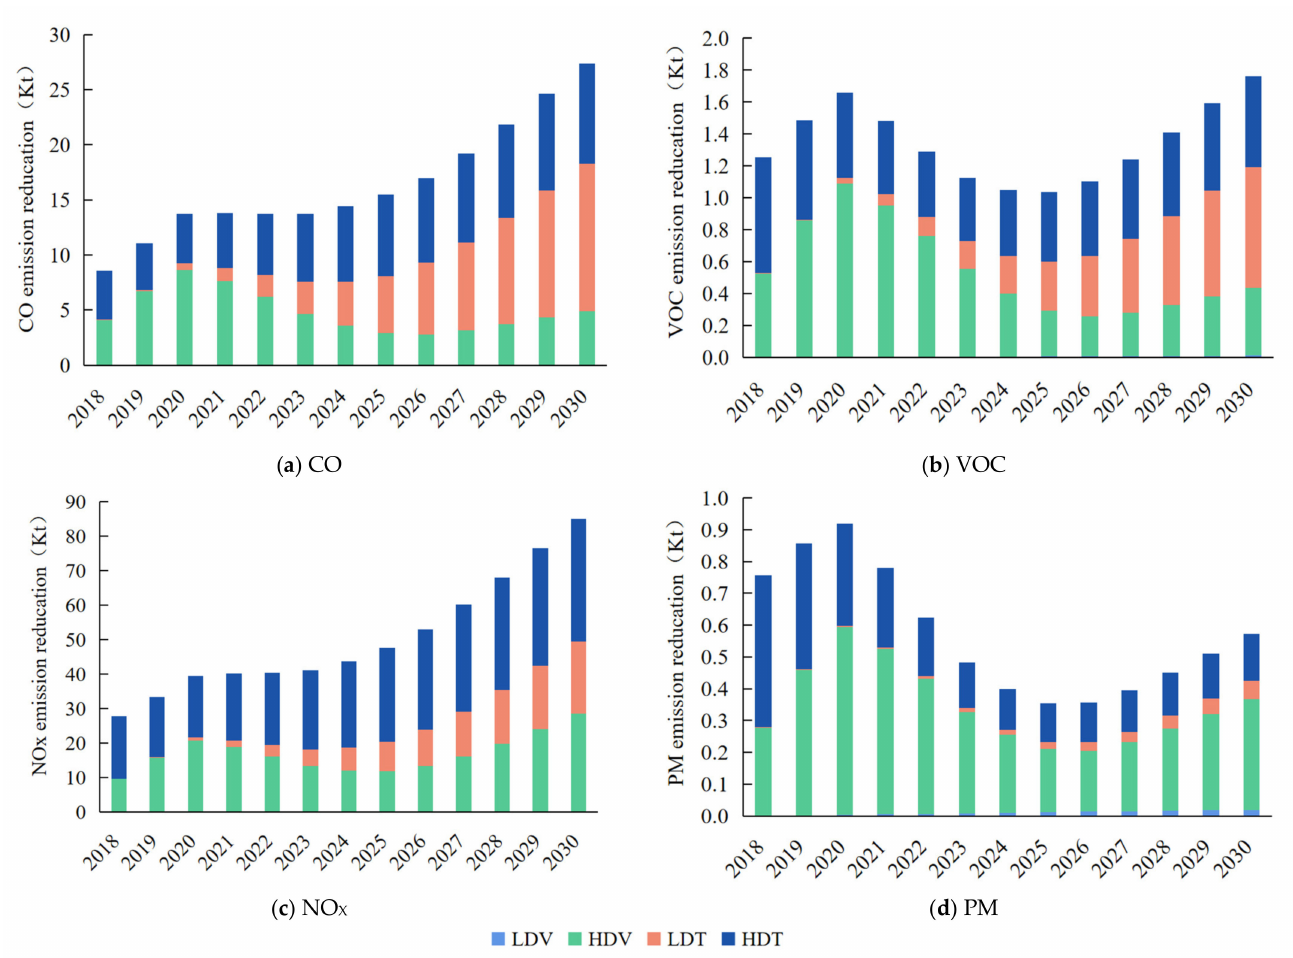
Figure 5. Pollutant emission reductions in diesel vehicles under the CS scenario in